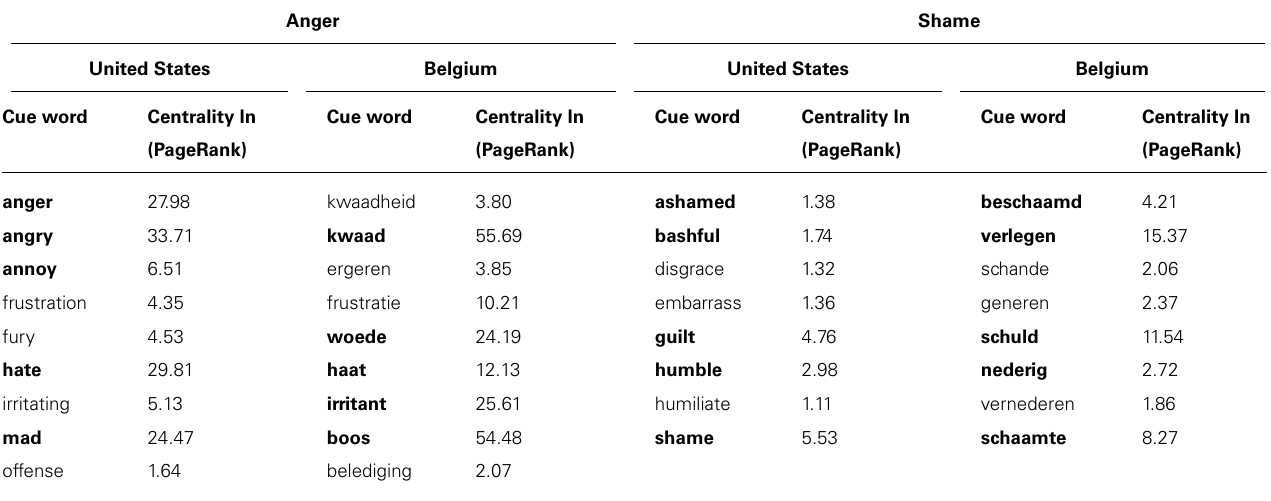
Table 2 | Selection of anger and shame words in Belgium and the United States. Anger Shame United States Belgium United States